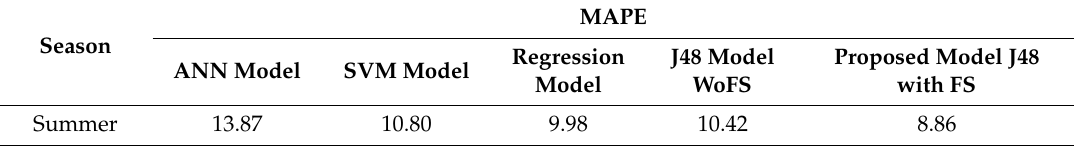
Table 7. Comparison of results of the proposed method with other forecasting methods.